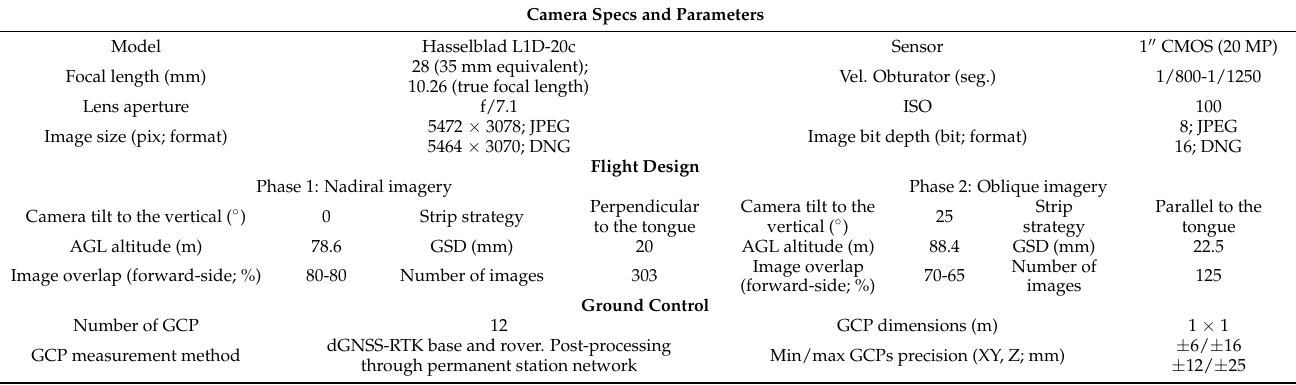
Table 1. UAV camera and photogrammetric survey characteristics. Camera Specs and